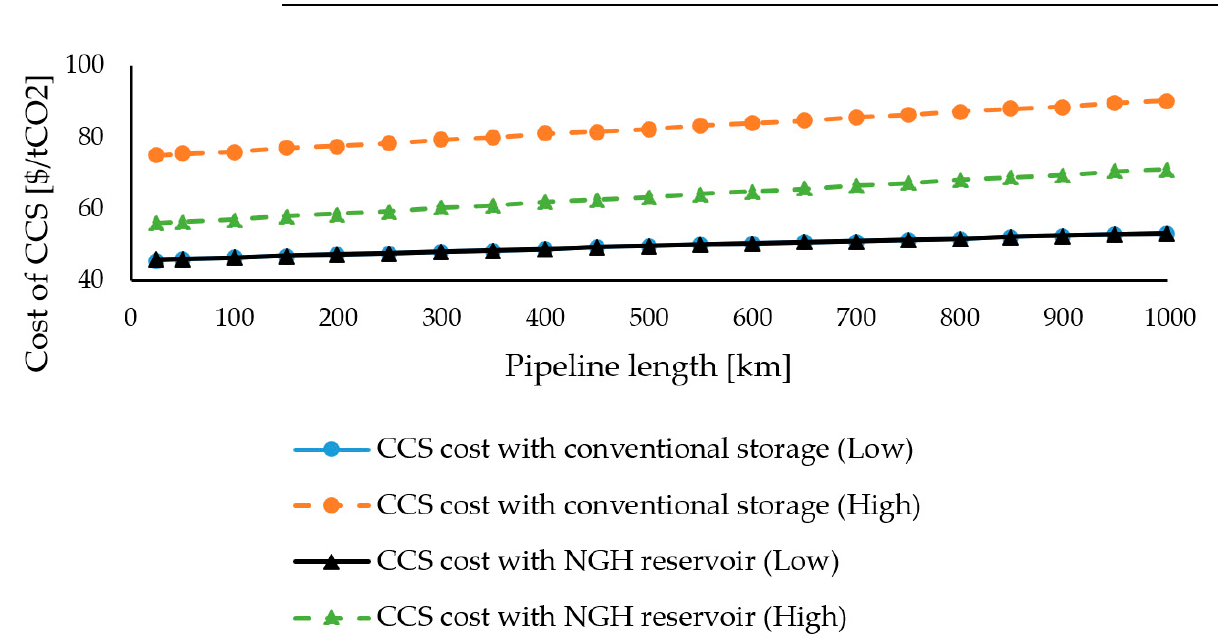
Figure 16. Cost of CCS at a different distance between source and storage. The continuous line represents the lower cost of CCS, while dashed lines are the higher value of CCS. The triangles indicate the CCS cost chain when methane is produced via depressurization and the CO 2 replacement, while the circles indicate the CCS cost chain with conventional storage sites described in Table 8.